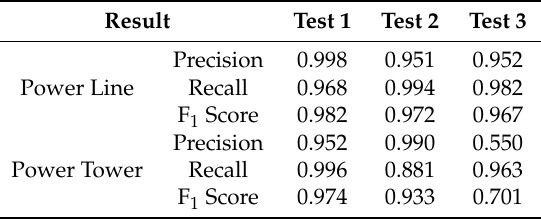
Figure 12. Robustness test: ( a ) data of test 1; ( b ) data of test 2; ( c ) data of test 3; ( d ) classification result of test 1; ( e ) classification result of test 2; and ( f ) classification result of test 3. Table 4. Classification accuracy statistics of test data.